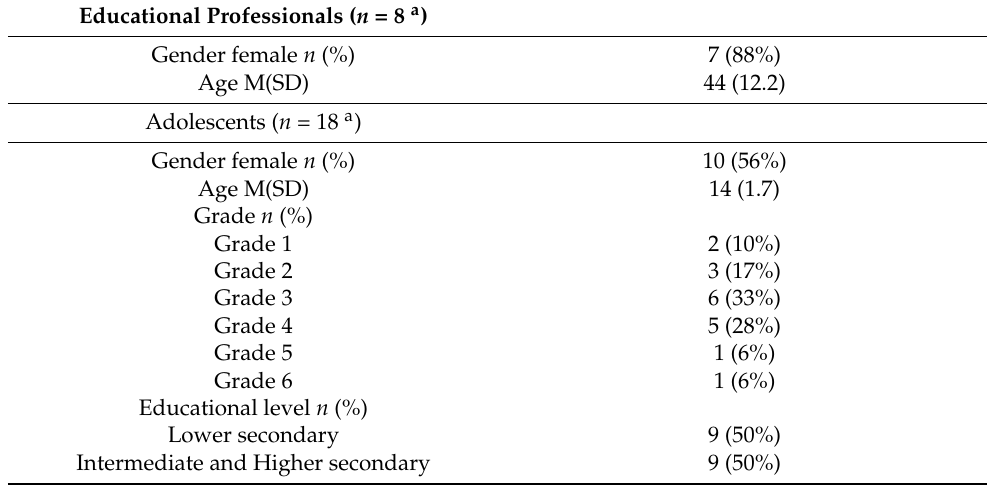
Table 2. Characteristics of the Sample of Educational Professionals and Adolescents.